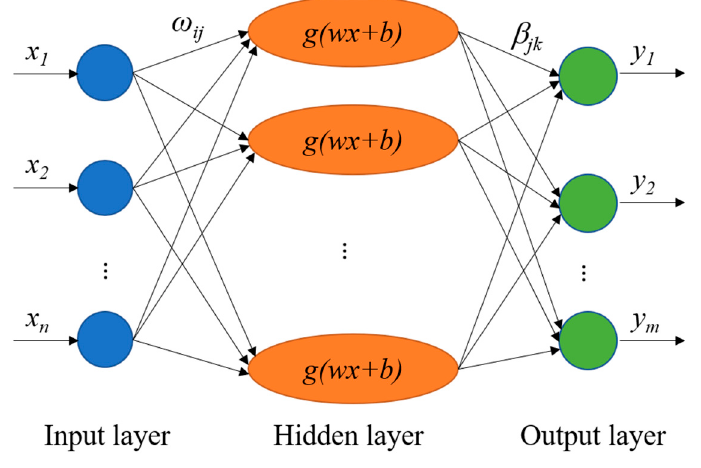
Figure 1. Neural network structure of ELM. Table 1. Algorithmic process of ELM. Algorithm of